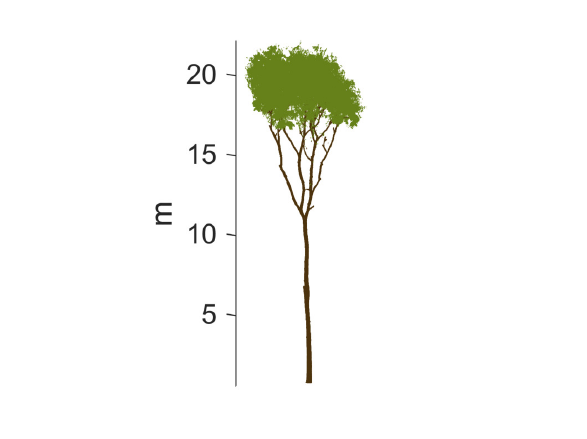
Figure 1. Point cloud of the Erytrophleum fordii .